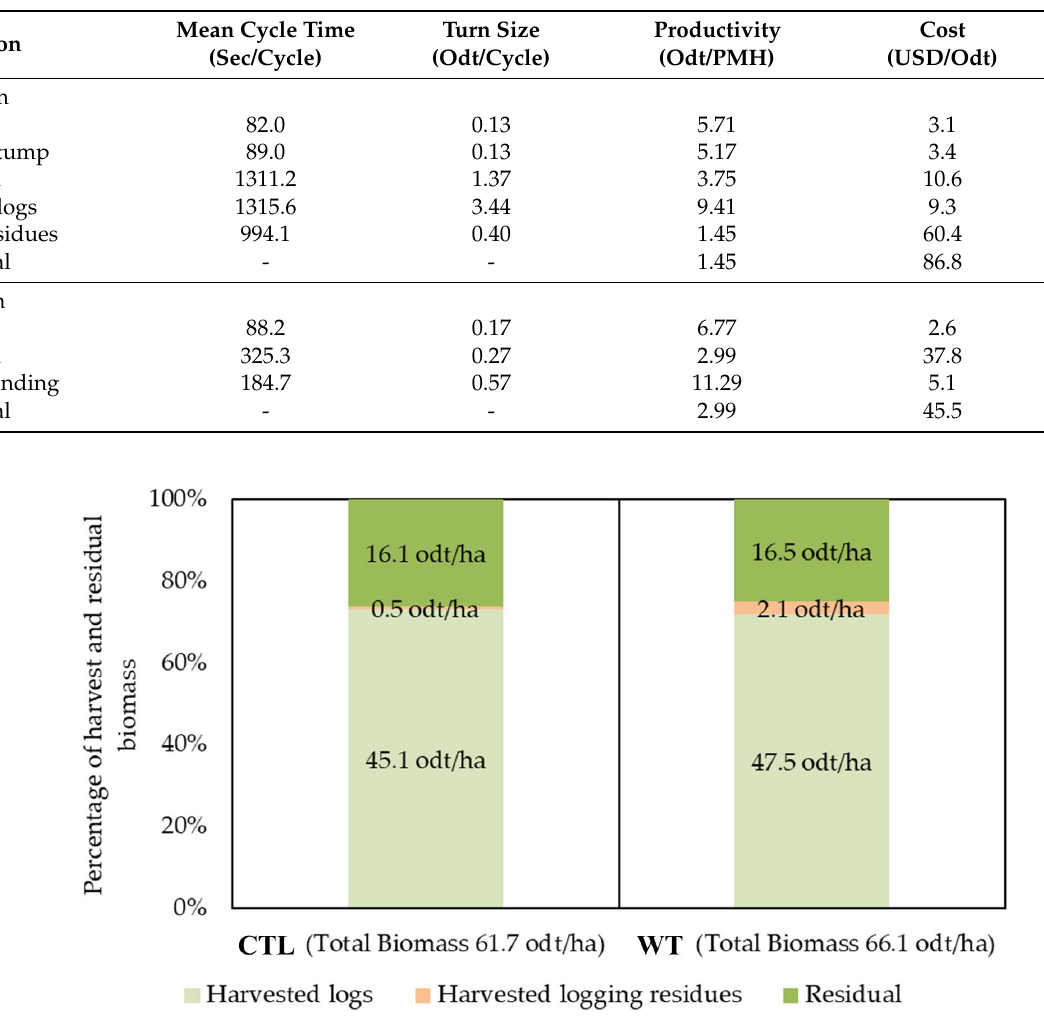
Figure 4. The amount of logging residue left and collected for each harvesting system.